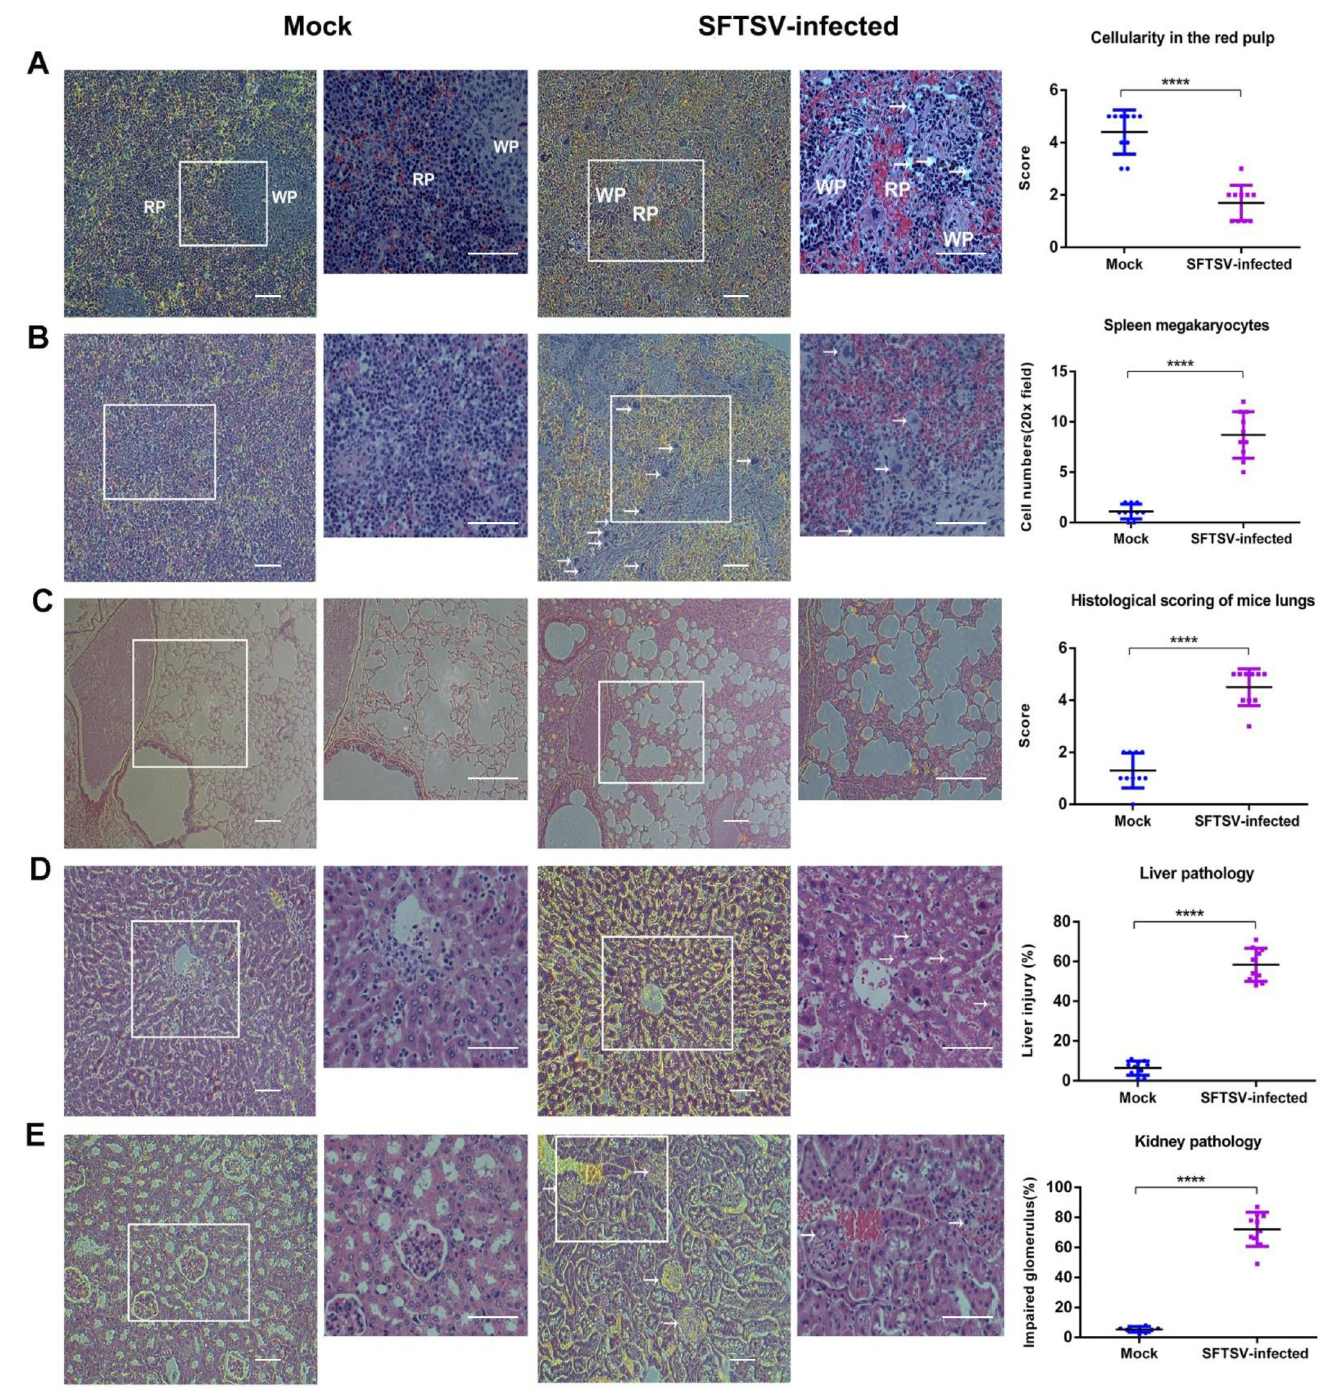
Fig 2. Histopathological lesions in SFTSV-Infected humanized mice. Dynamic profile of pathological changes in mice infected with SFTSV. Representative H&E-stained tissue sections from SFTSV-infected mice and mock mice. Areas of interest (AOI) are enlarged, and quantitative graphs are presented at the right. (A) Decreased cellularity and obvious lymphocyte depletion in the red pulp (RP) of the spleen at sacrificed day. (B) The number of megakaryocytes increased significantly in the spleen. (C) According to the inflammation of pulmonary interstitium, the thickening of alveolar septum and the structural integrity of pulmonary vesicles, the scores are divided into five grades. In the C images and AOI, structure of the alveoli was obviously destroyed, and the alveoli were filled with inflammatory substances. There was no obvious alveolar septum. (D) In liver, arrowheads show hepatocyte necrosis with shrinking nucleic or hepatocyte degradation with balloon-like empty cytoplasm. (E) In the kidney, arrowheads show impaired renal capsules. Bleeding was observed and the space between glomerulus and surrounding tissue was blurred. In figures, the images and AOI are 100 × and 200 × , respectively. Bar = 50 μ m. In quantitative graphs, red dots and blue dots indicate SFTSV-infected mice and mock mice, respectively. Data are shown as mean ± SEM of three independent experiments. ( ���� p < 0.001). https://doi.org/10.1371/journal.ppat.1009587.g002 PLOS Pathogens| https://doi.org/10.1371/journal.ppat.1009587 May 11,